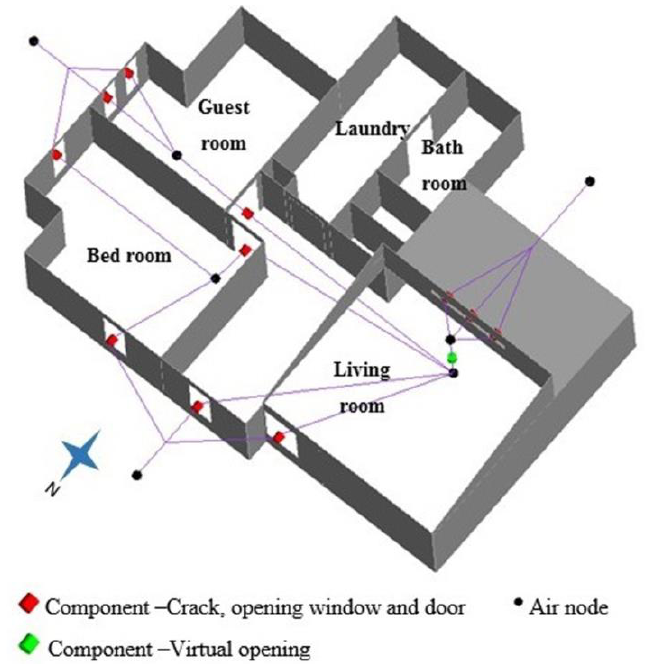
Figure 4. Schematic of the airflow nodal network.